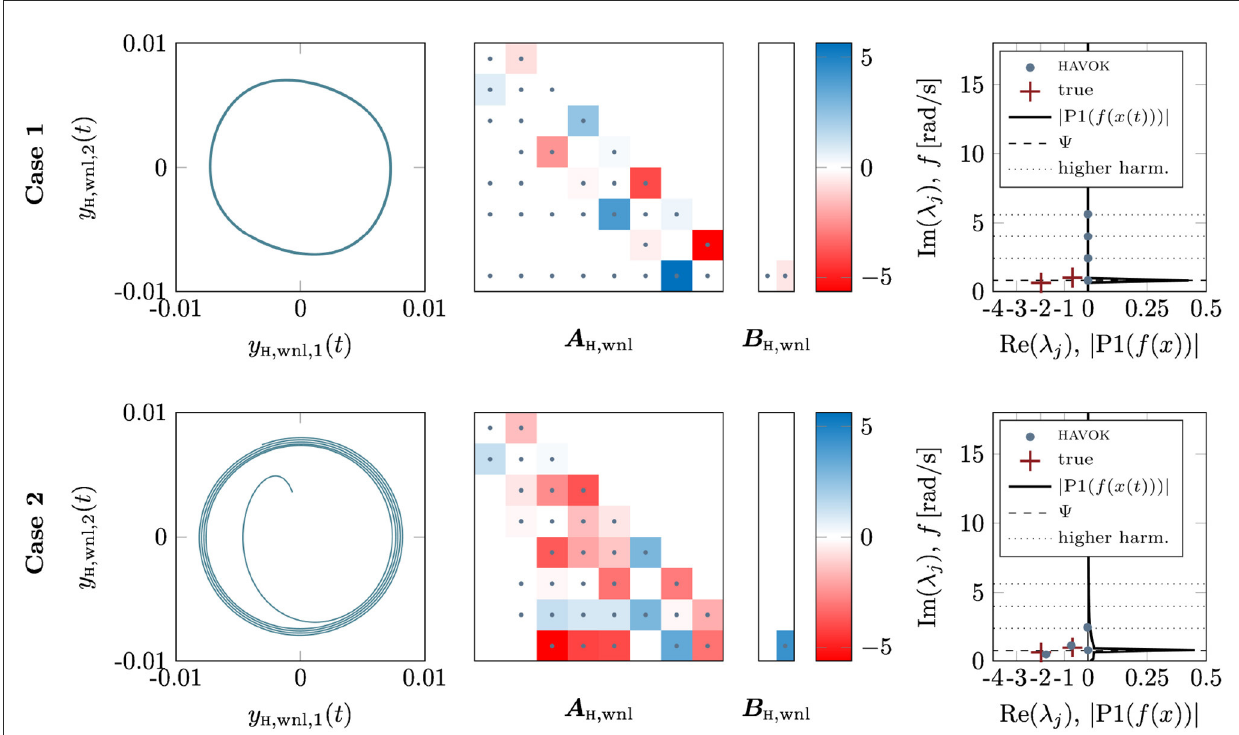
FIGURE9 Case studies of the weakly non-linear double-mass-oscillator. (Top) The HAVOK model obtained when omitting all transient motion in the input time series. (Bottom) The HAVOK model for a DMO when the non-linearity is moved to the other end of the oscillator chain, away from the excitation and the input time series. For both systems, the state space resulting from the first two HAVOK trajectories y H,wnl,1 and y H,wnl,2 are shown, as well as the state and input matrices. On the right, the HAVOK model eigenvalues are compared to the true DMO system eigenvalues, the frequency spectrum P 1 | f ( x ) | of the input time series and the forcing